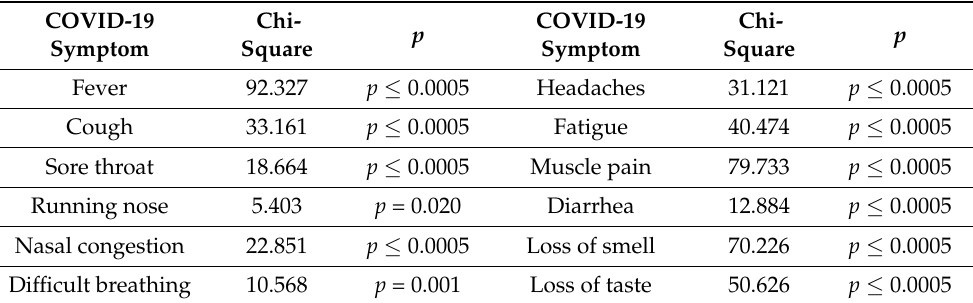
Table 3. Differences in COVID-19 symptoms between the 2020 and 2022